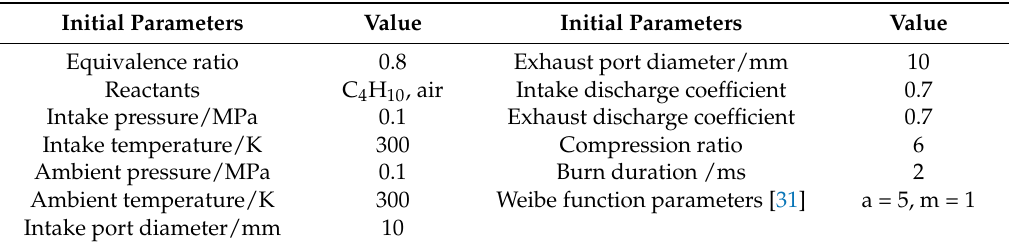
Figure 8. Working cycle of the micro swing rotor engine in steady state. Table 2. Initial parameters of the micro swing rotor engine.